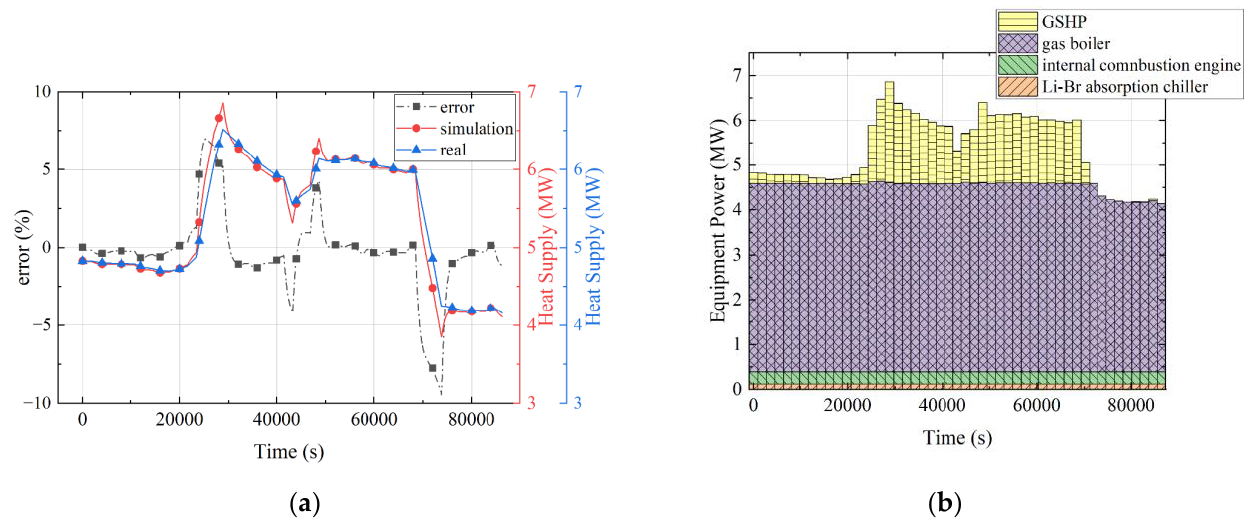
Figure 6. Dynamic operation of the IES model. ( a ) heat load; ( b ) equipment power.